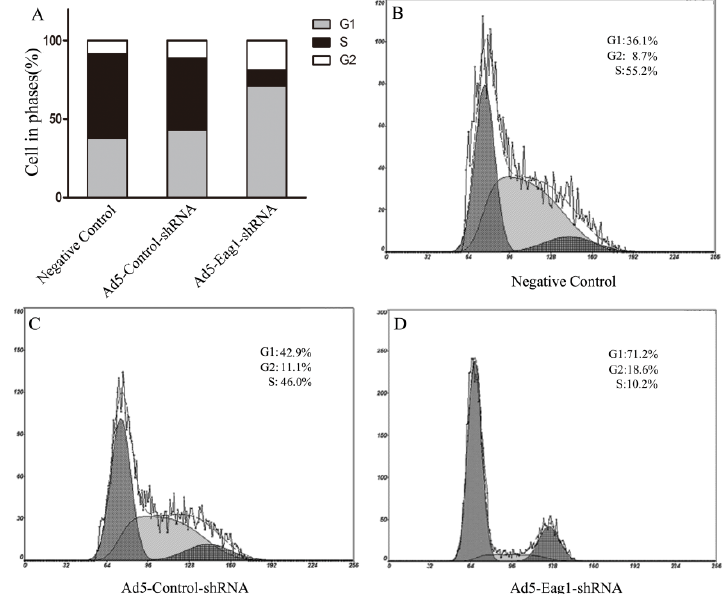
Figure 4. The effects of Eag1-shRNA on cell cycle progression of MG-63